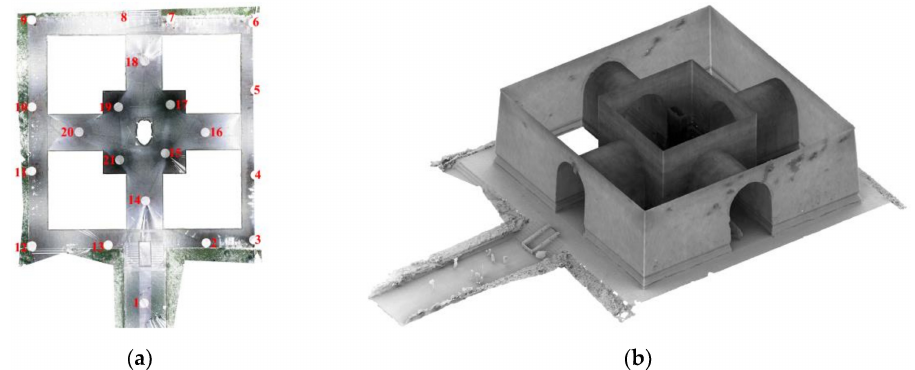
Figure 5. The GTM of the Pavilion. ( a ) The plan and scanning stations (highlighted in red); and ( b ) the mesh model.